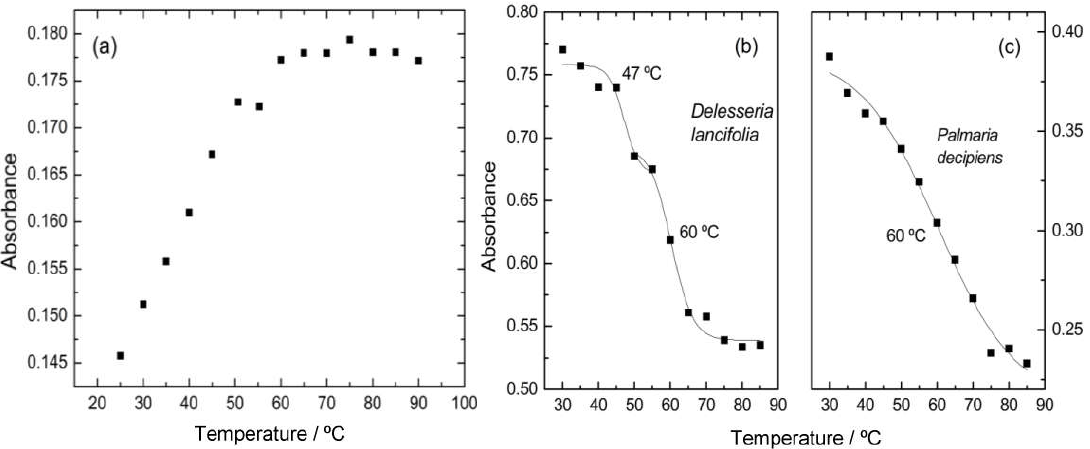
Figure 7. Graphical representation of the absorbance values vs. temperature for ( a ) an anthocyanins solution; ( b ) for R-phycoerythrin extracted from Delesseria lancifolia ; ( c ) for R-phycoerythrin extracted from Palmaria decipiens .